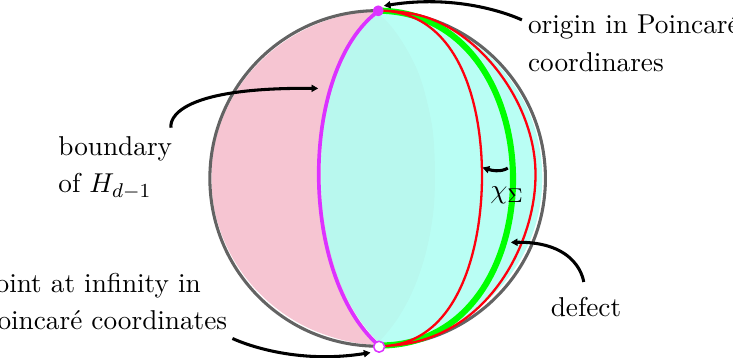
Figure 11. A time-slice of our setup. The spatial boundary S d − 1 (in global coordinates) is split into two hyperbolic discs H d − 1 , shown in pink and aqua, which are glued together at infinity. At the same location, the bifurcate horizon intersects the boundary. The CFT on either disc is dual to a Rindler wedge in the bulk. The defect (green) is a great circle on the global boundary. As indicated in the figure, the Poincaré coordinates introduced in this section cover the full sphere, with the point at infinity appearing on the south pole of the sphere. Entangling surfaces are the semi-circles shown in